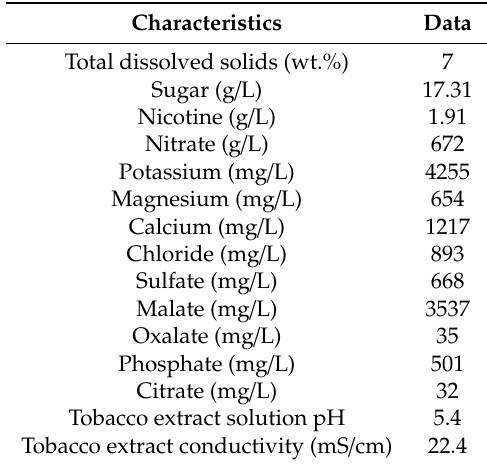
Table 1. The main characteristics of tobacco